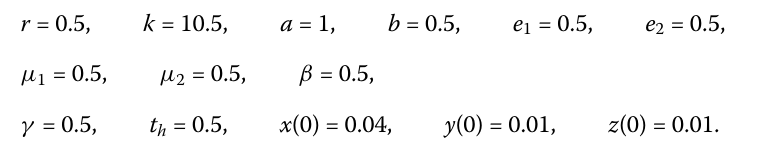
f ( x ) = ax . Then f –1 ( x ) = x , and based on Remark 3.1 for the existence of x 2 , we a (1– t h x ) 1+ at h x < 1 , and the functional g to be a Holling I interaction must have μ 1 e 1 t h